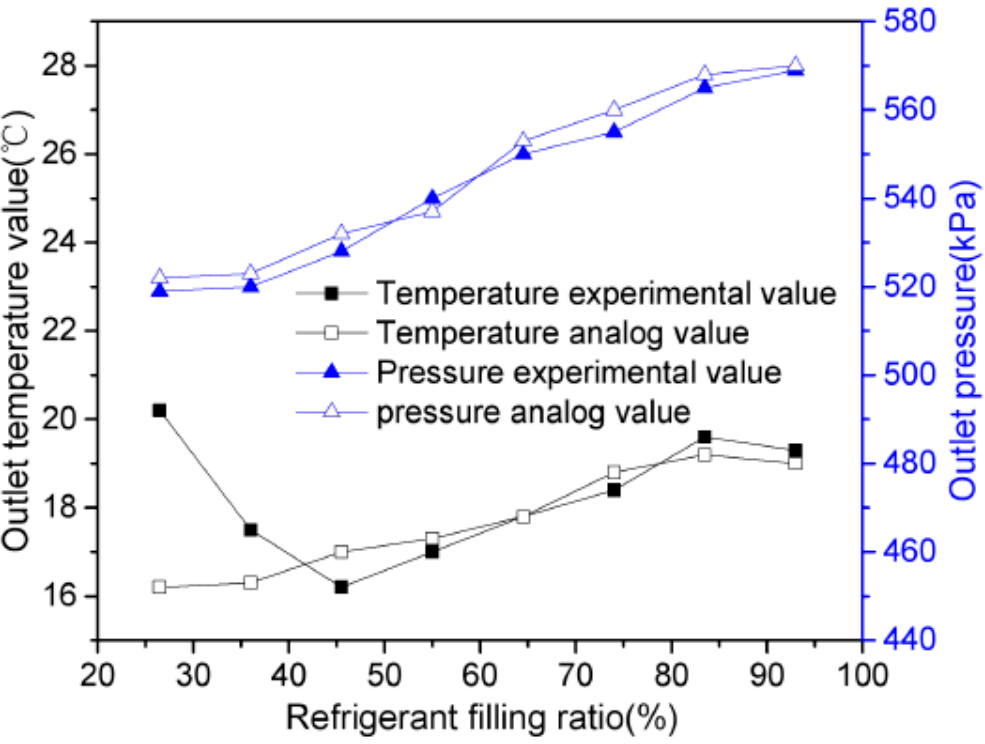
Figure 10. Temperature and pressure comparison of CDU outlet refrigerant.